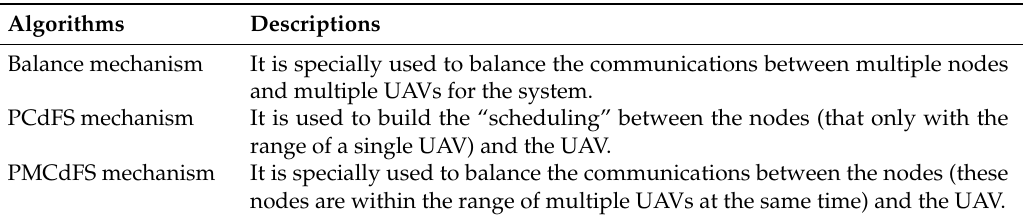
Table 3. Proposed algorithms.